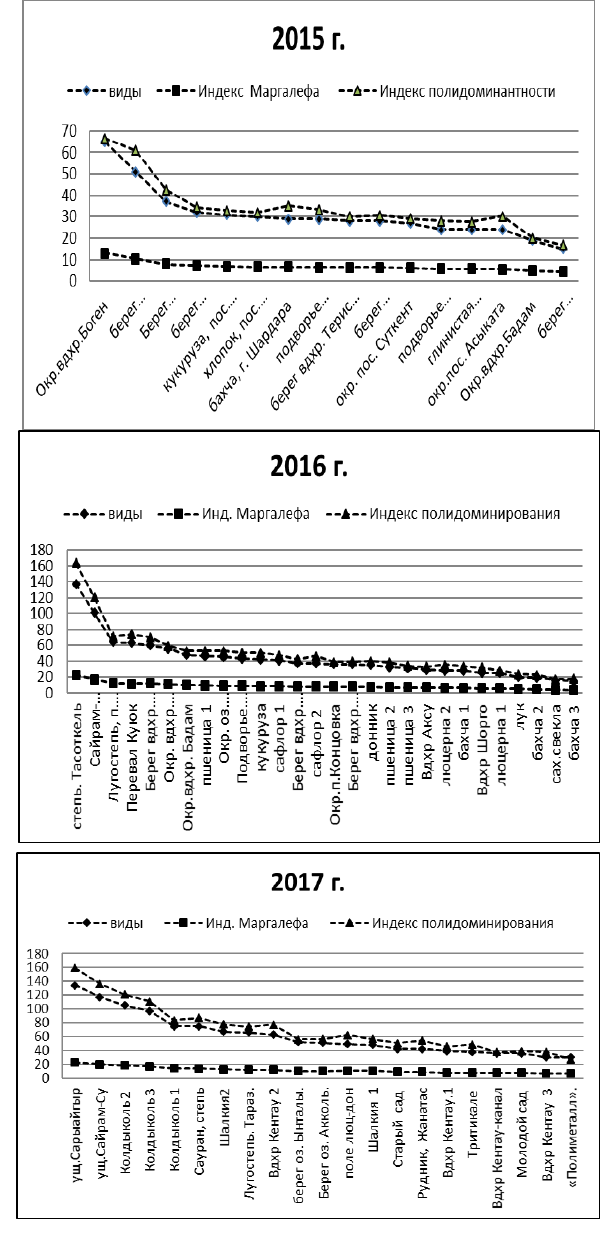
Рис. 3. Особенности изменения индексов видового разнообразия для исследованных в 2015-2017 гг. энтомоценозов, ранжированных в соответствии с числом зарегистрированных видов Для всех исследованных нами случаев значения этого индекса были практически одинаковыми, находясь в интервале (0,94-0,99), что указывает на его невысокую информативность при пятибалльной оценке численности. Более заметными различиями в величине индексов были индексы Менхиника (1,95-3,13) и индекс Шеннона (3,64 - 6,97). Следует отметить, что необходимым условием для использования последнего индекса является редко выполняемое на практике, в том числе и в рассматриваемом нами случае, требование соответствия числа видов